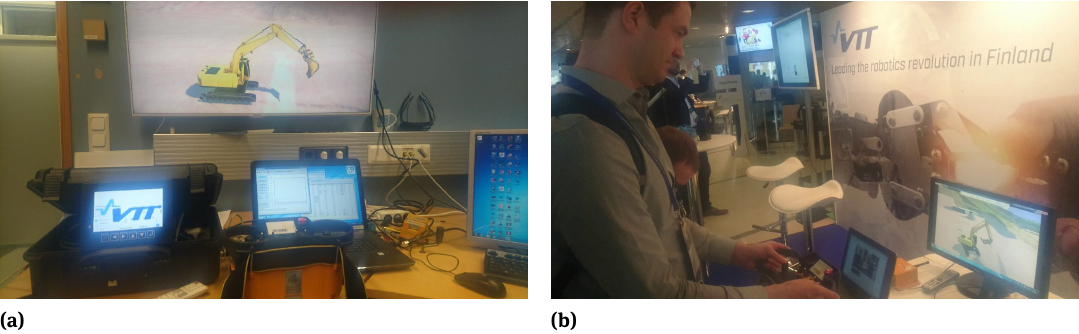
Figure 5: Demonstration of the open loop remote control: a virtual mobile machine with a hardware-in-the-loop controller in Oulu (a) and a remote operator with an industrial wireless transmitter and video feedback in Tampere (b).